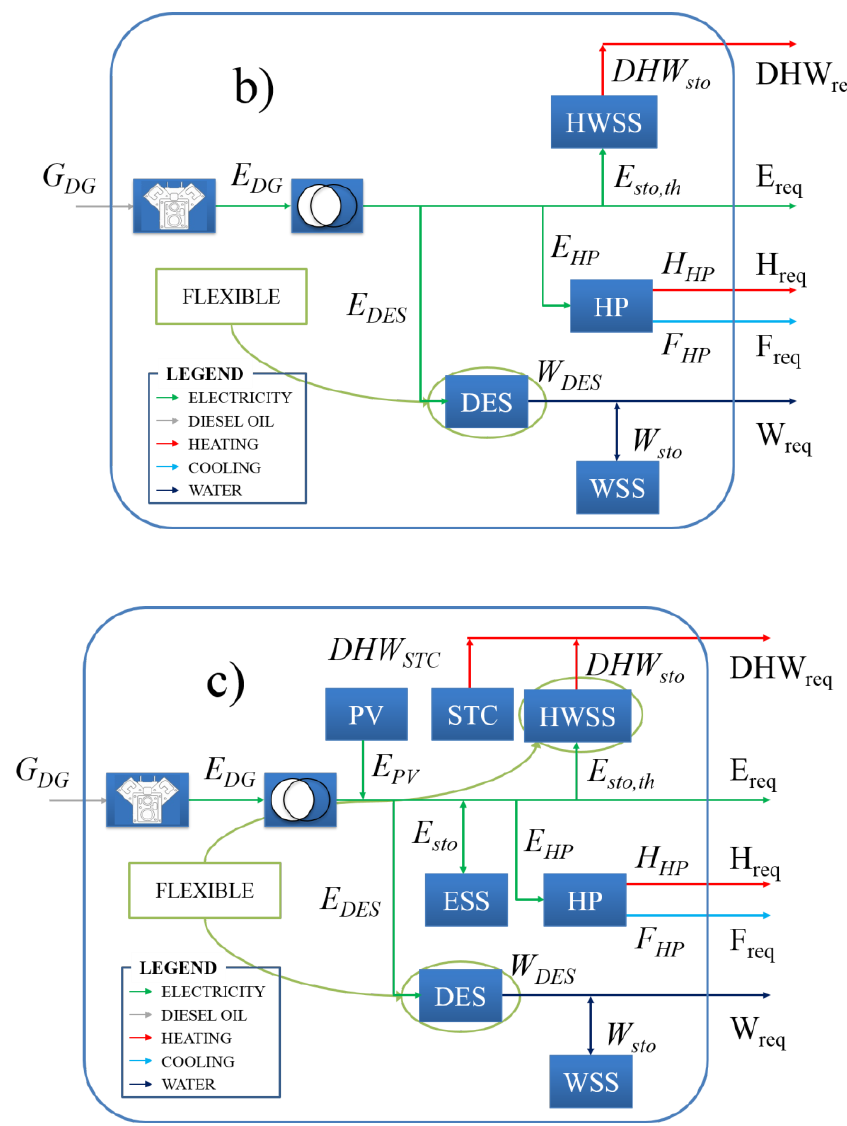
Figure 7. Scheme of the energy system in Pantelleria: ( a ) AS-IS scenario; ( b ) TO-BE scenario 1; ( c ) TO-BE scenario 2.